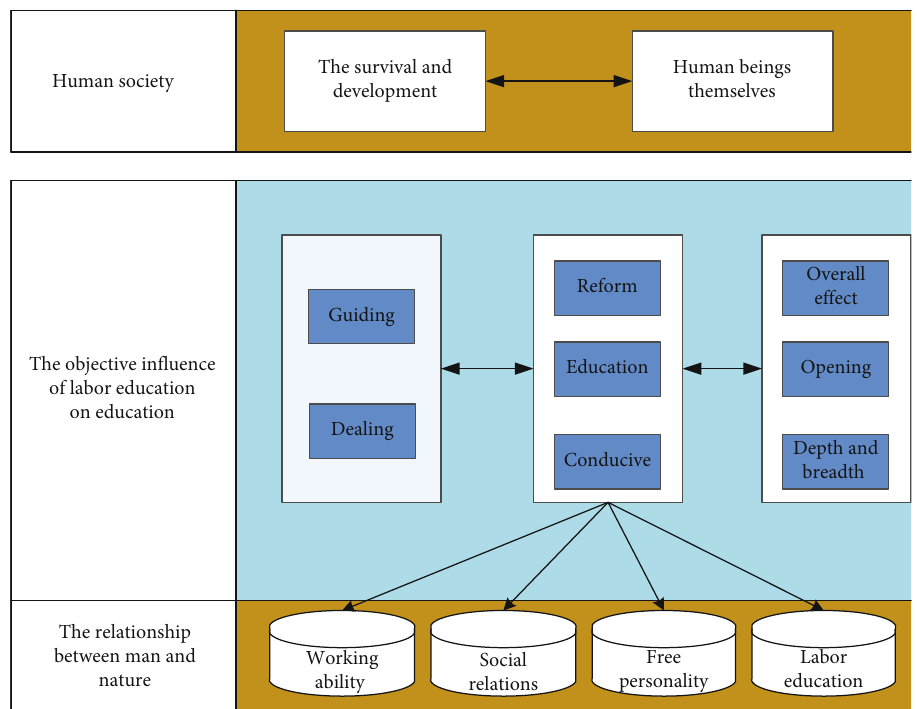
Figure 1: Framework for implementing labor education.